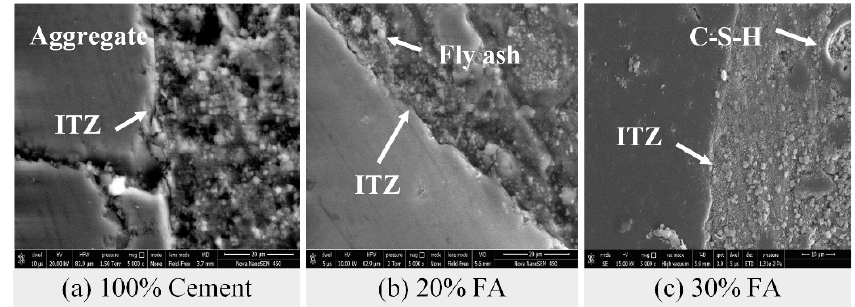
Figure 7. SEM images of SCC mixes at different levels of fly ash [25].